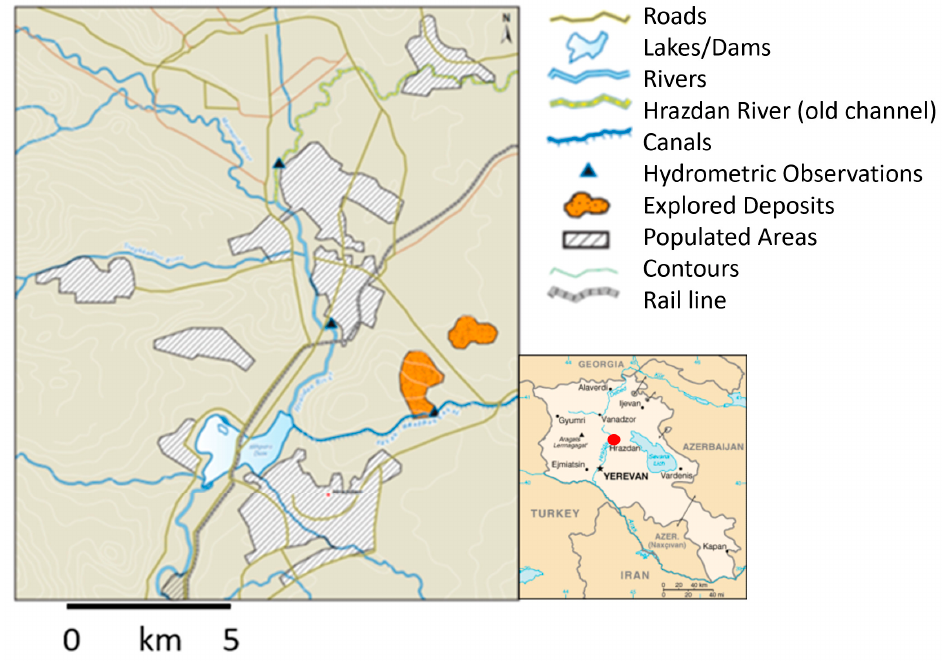
Figure 1. Location map (insert map shows location of Armenia and Hzradan to the north of Yerevan, the capital as a red dot).